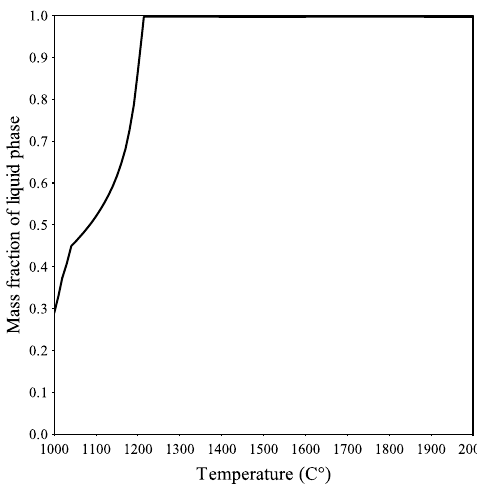
Figure 7. The mass fraction of liquid phase for the slags used in Trials 1 and 2 for a temperature span between 1000 and 2000 °C. The calculations were made for a closed system.